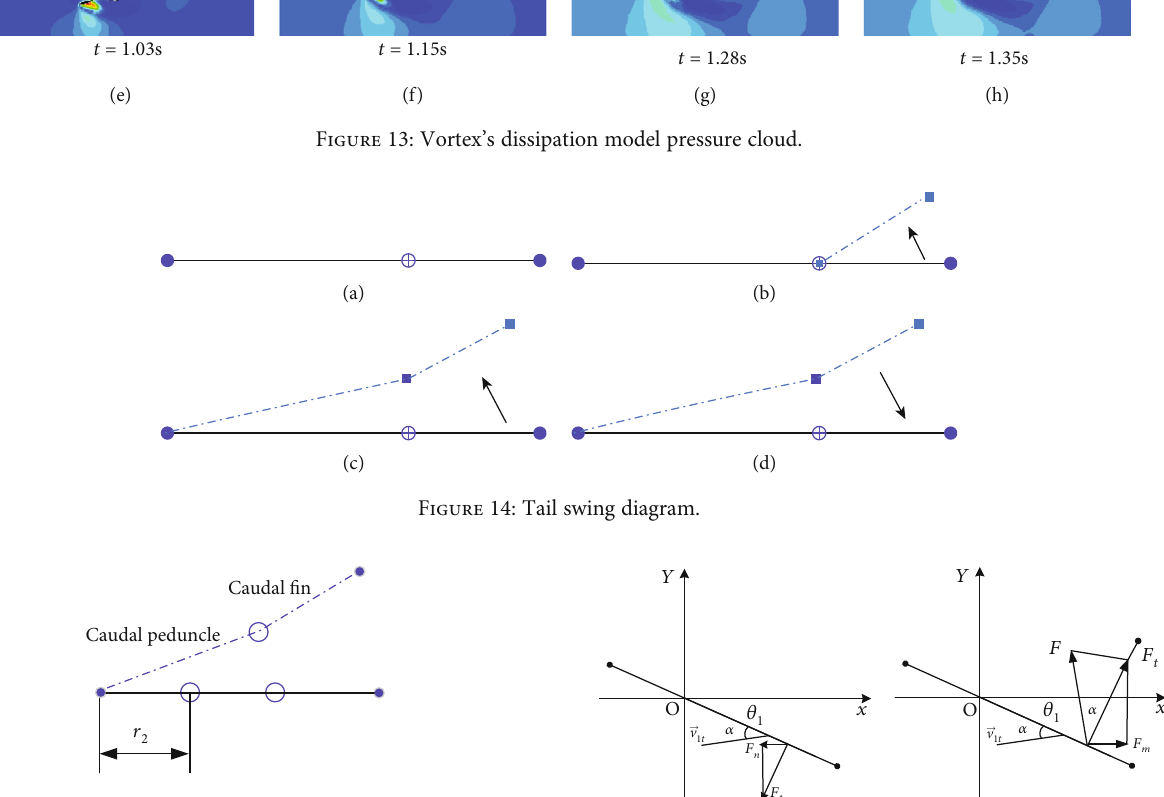
Figure 15: Schematic diagram of caudal peduncle swing.